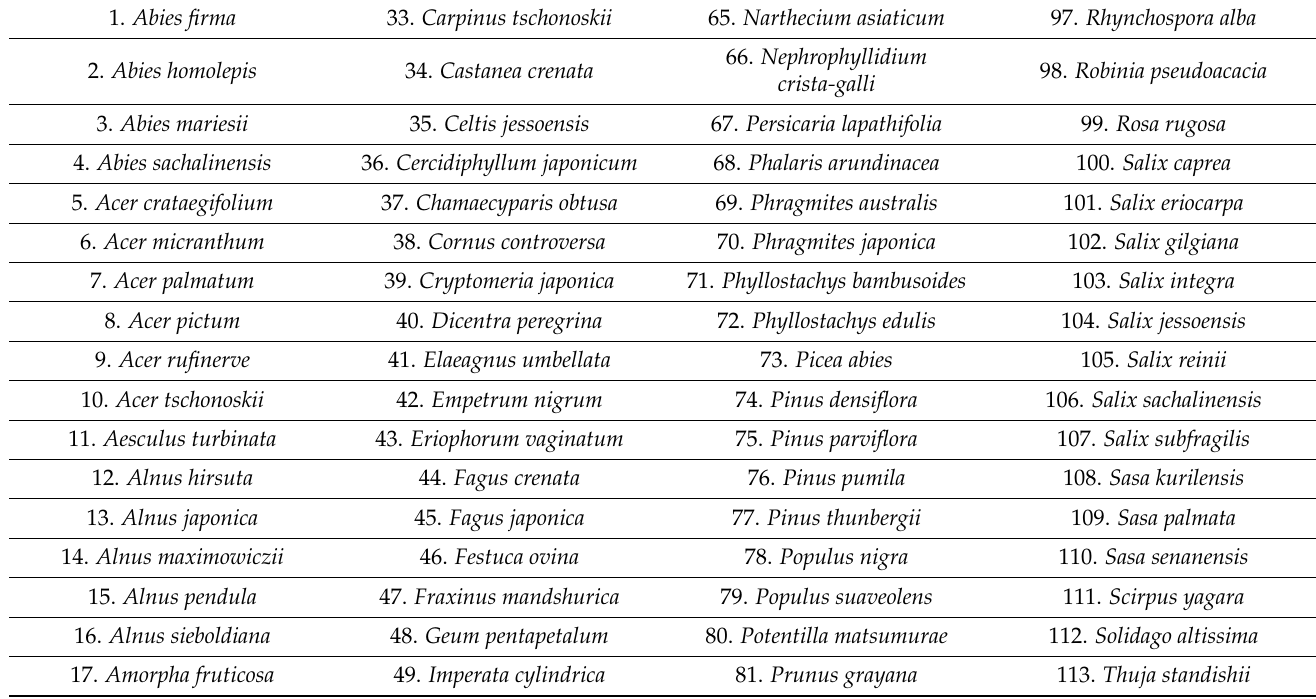
Table 1. List of the dominant plant species of the Tohoku region enumerated in the research.